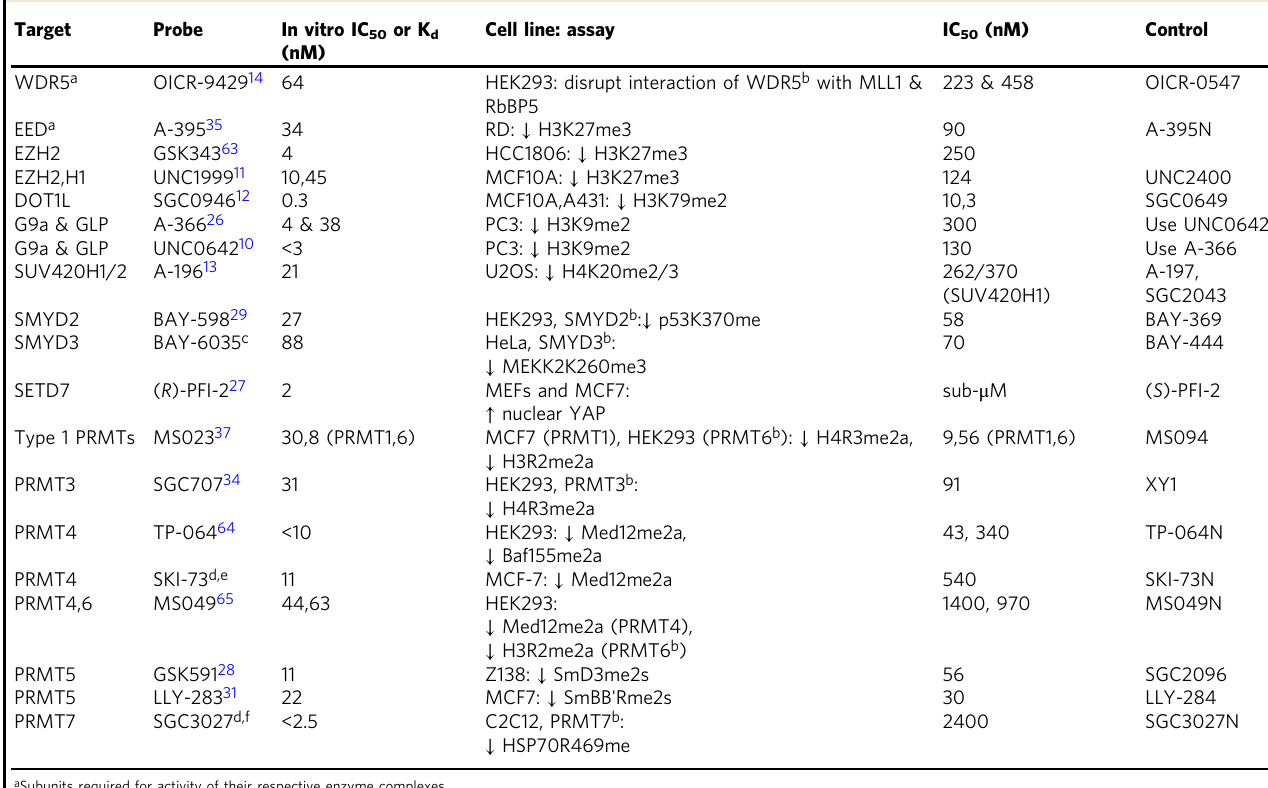
Table 1 Summary of chemical probes and their chemotype-matched controls for protein methyltransferases. Related to Fig. 1a – c, Supplementary Figs. 1 and 2